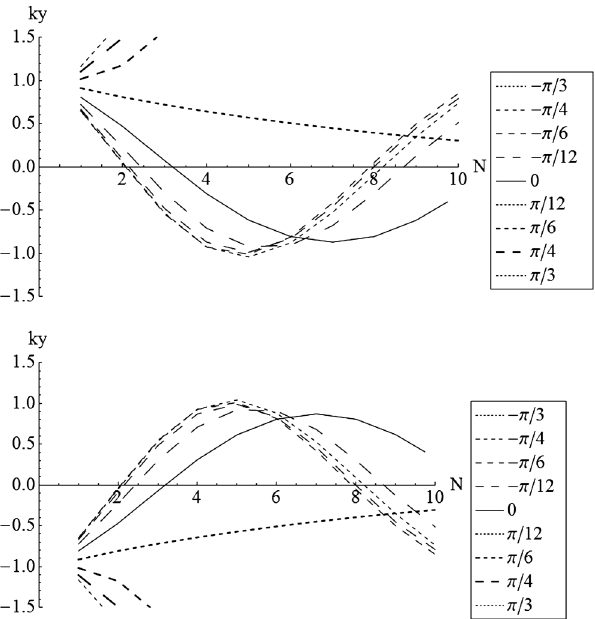
for 100 MeV electrons injected along x at different positions in the z axis. The electrons are injected with an offset in y equal to π = 3 (top plot) and to − π = 3 (bottom